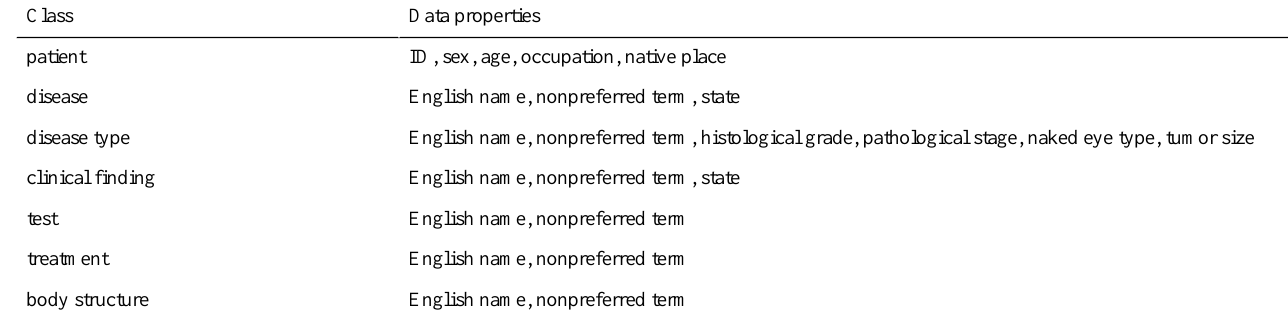
Table 1. Data properties of the digestive system tumor knowledge graph